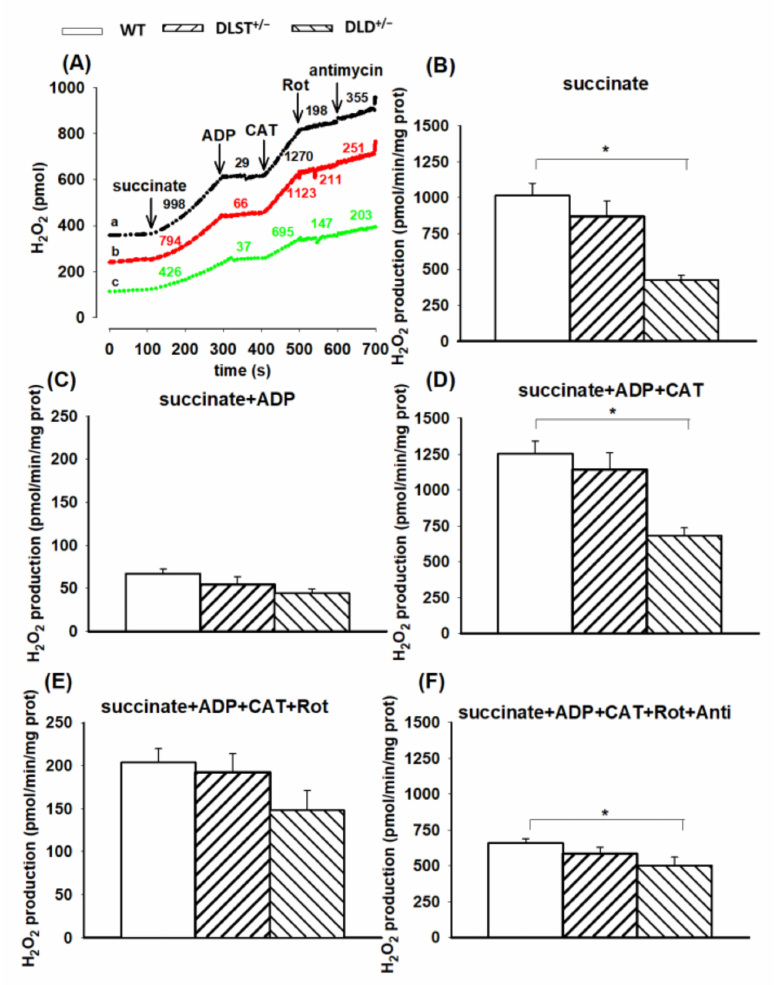
Figure 5. Hydrogen peroxide production in the wild-type and KGDHc-subunit-KO mitochondria respiring on succinate. H 2 O 2 production was measured with the Amplex UltraRed assay as described under Materials and Methods. ( A ) Traces represent single independent experiments and are offset for clarity. Trace a (black): wild-type (WT), trace b (red): DLST +/ − , trace c (green): DLD +/ − . Mitochondria (0.1 mg/mL) were incubated in the standard medium which was followed by the addition of succinate (5 mM), ADP (2 mM), carboxyatractilozide (CAT, 2 µ M), rotenone (Rot, 250 nM), and antimycin A (2 µ M) as indicated. Numbers on the traces represent H 2 O 2 production expressed in pmol/min/mg protein. H 2 O 2 production was measured in the presence of succinate ( B ), after adding ADP ( C – F ), CAT ( D – F ), rotenone ( E , F ) and antimycin A ( F ). All other conditions and representations are as in Figure 1. Statistically significant differences are indicated by asterisks; * p <